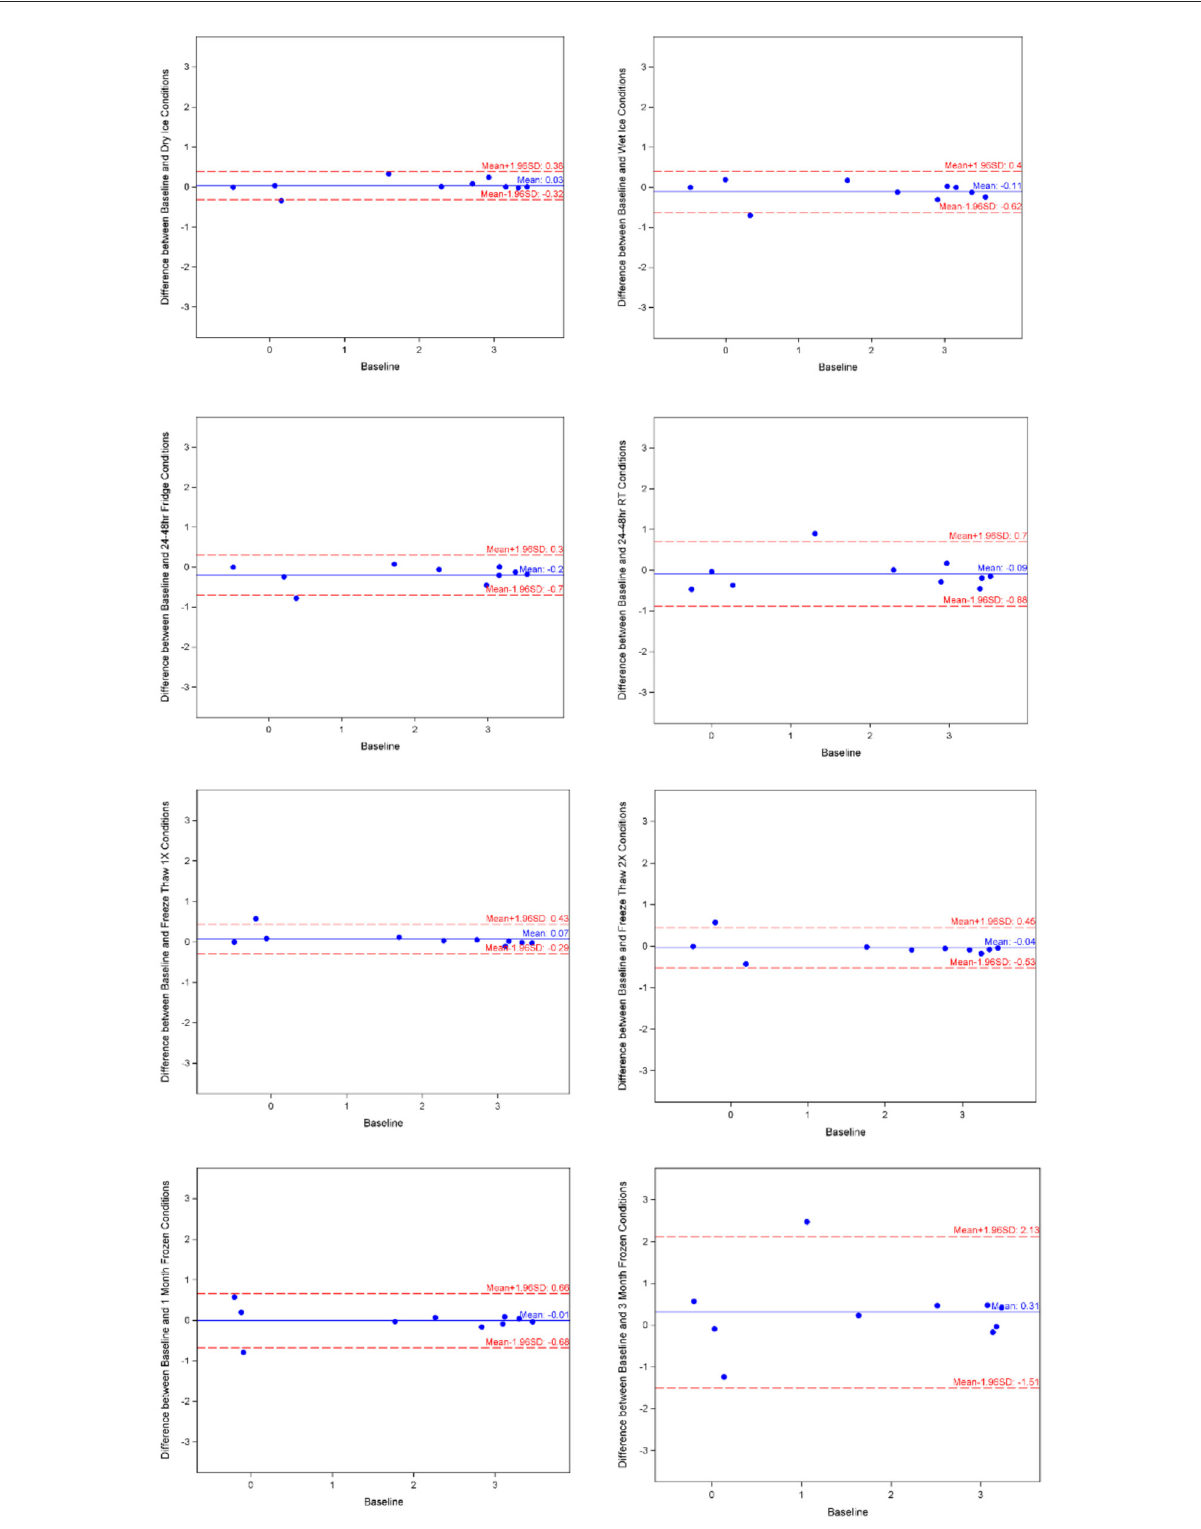
FIGURE2 Adiponectin Bland-Altman charts by experimental condition. Image made with